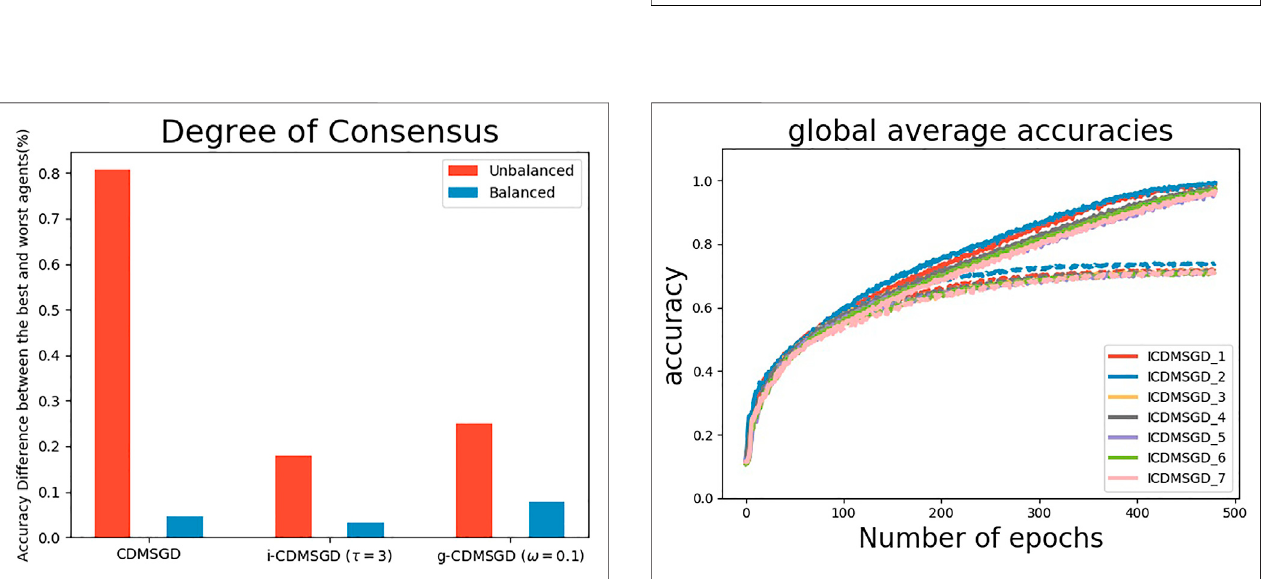
FIGURE 5 | The accuracy percentage difference between the best and the worst agents with balanced sample distribution for CDMSGD, i-CDMSGD and g-CDMSGD (varying ω .).